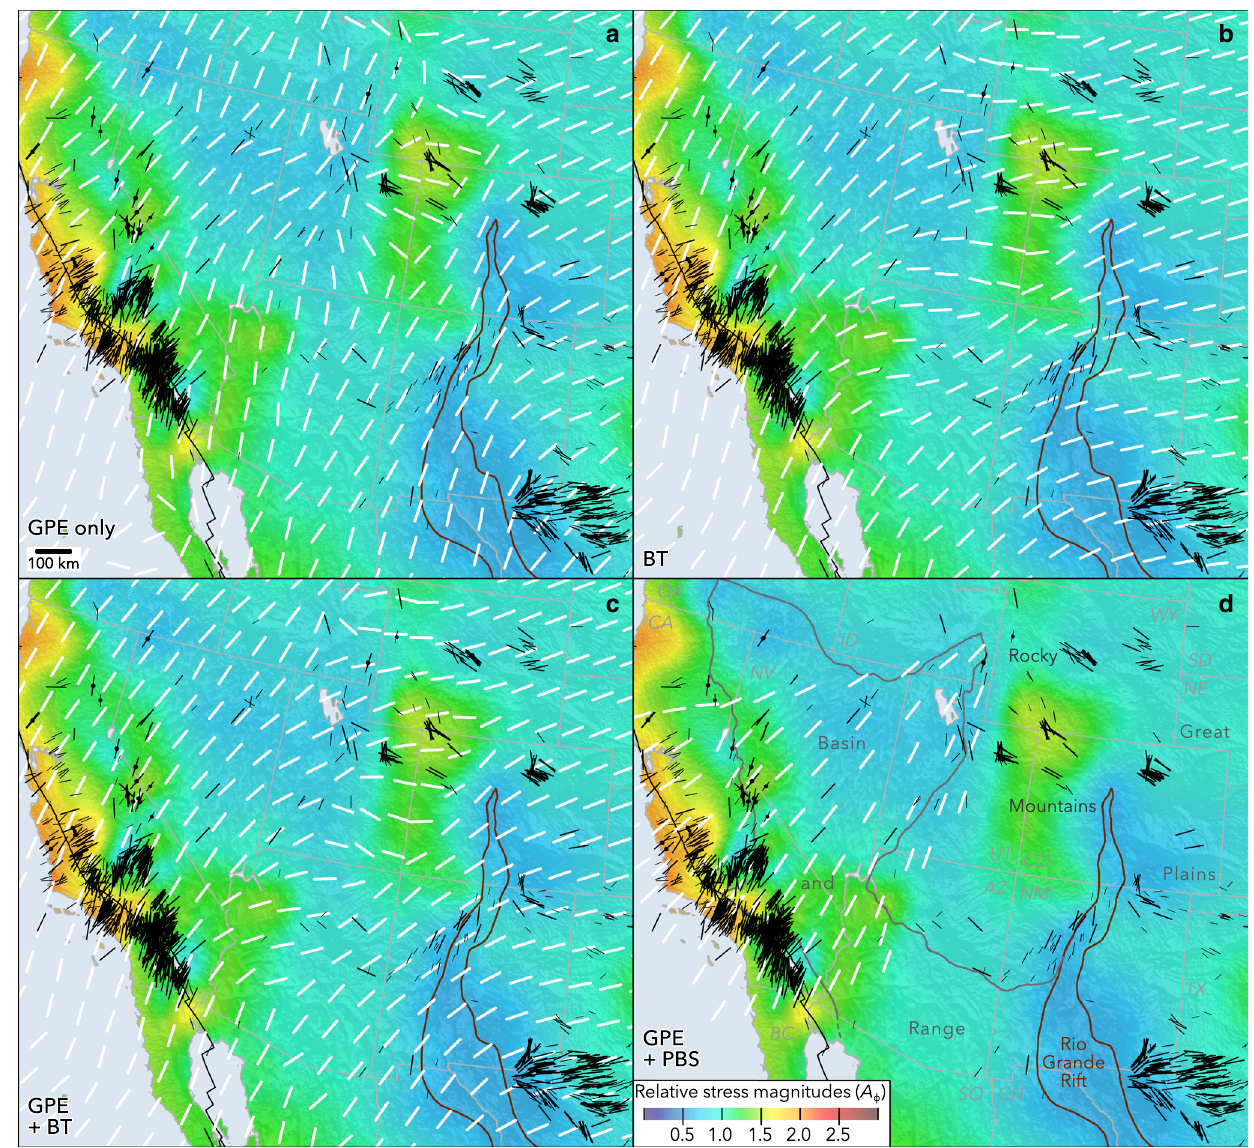
Fig. 4 Observed (black lines and colored background) and modeled (white lines) stress fi elds in the southwestern USA, showing considerable spatial variability. a – c Modeled S Hmax orientations by Ghosh et al. 4 that account for a only gravitational potential energy (GPE), b basal tractions (BT) from modeled mantle fl ow, and c a combination of GPE and BT. d A model of S Hmax orientations by Flesch et al. 47 that considered a smaller study area incorporated only GPE and plate boundary stresses (PBS), using simpler inputs and a smaller study